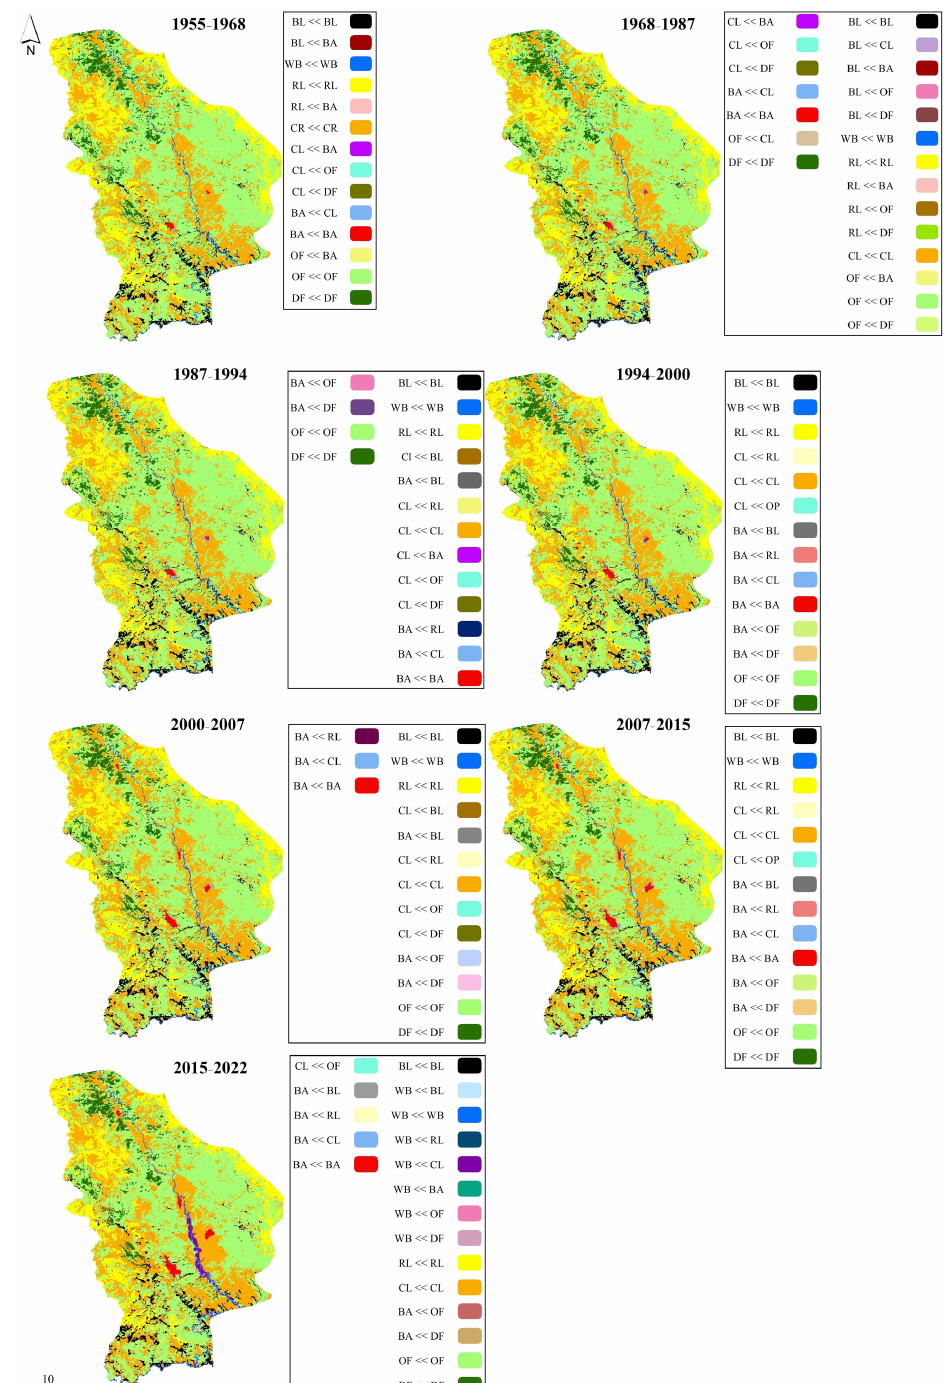
Figure 8. Change of land use/cover classes to other types. Legend: DF—dense forest, OF—open forest, BA—built-up areas, CL—croplands, RL—rangelands, WB—waterbodies, BL—barren lands). “<<” symbol denotes the conversion of one land use to